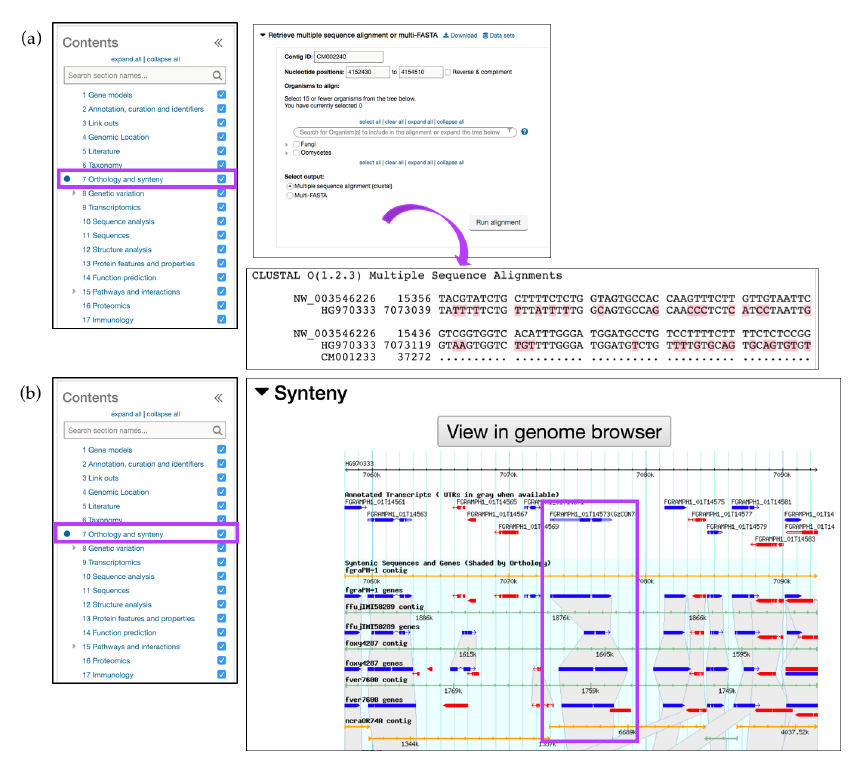
Figure 3. Simple searches and gene record pages, continued. Orthology and Synteny section (highlighted in purple) for the F. graminearum gene FGRAMPH1_01G14573. (http://fungidb.org/gene/FGRAMPH1_01G14573) ( a ) A Multiple Sequence Alignment (MSA) run within the gene